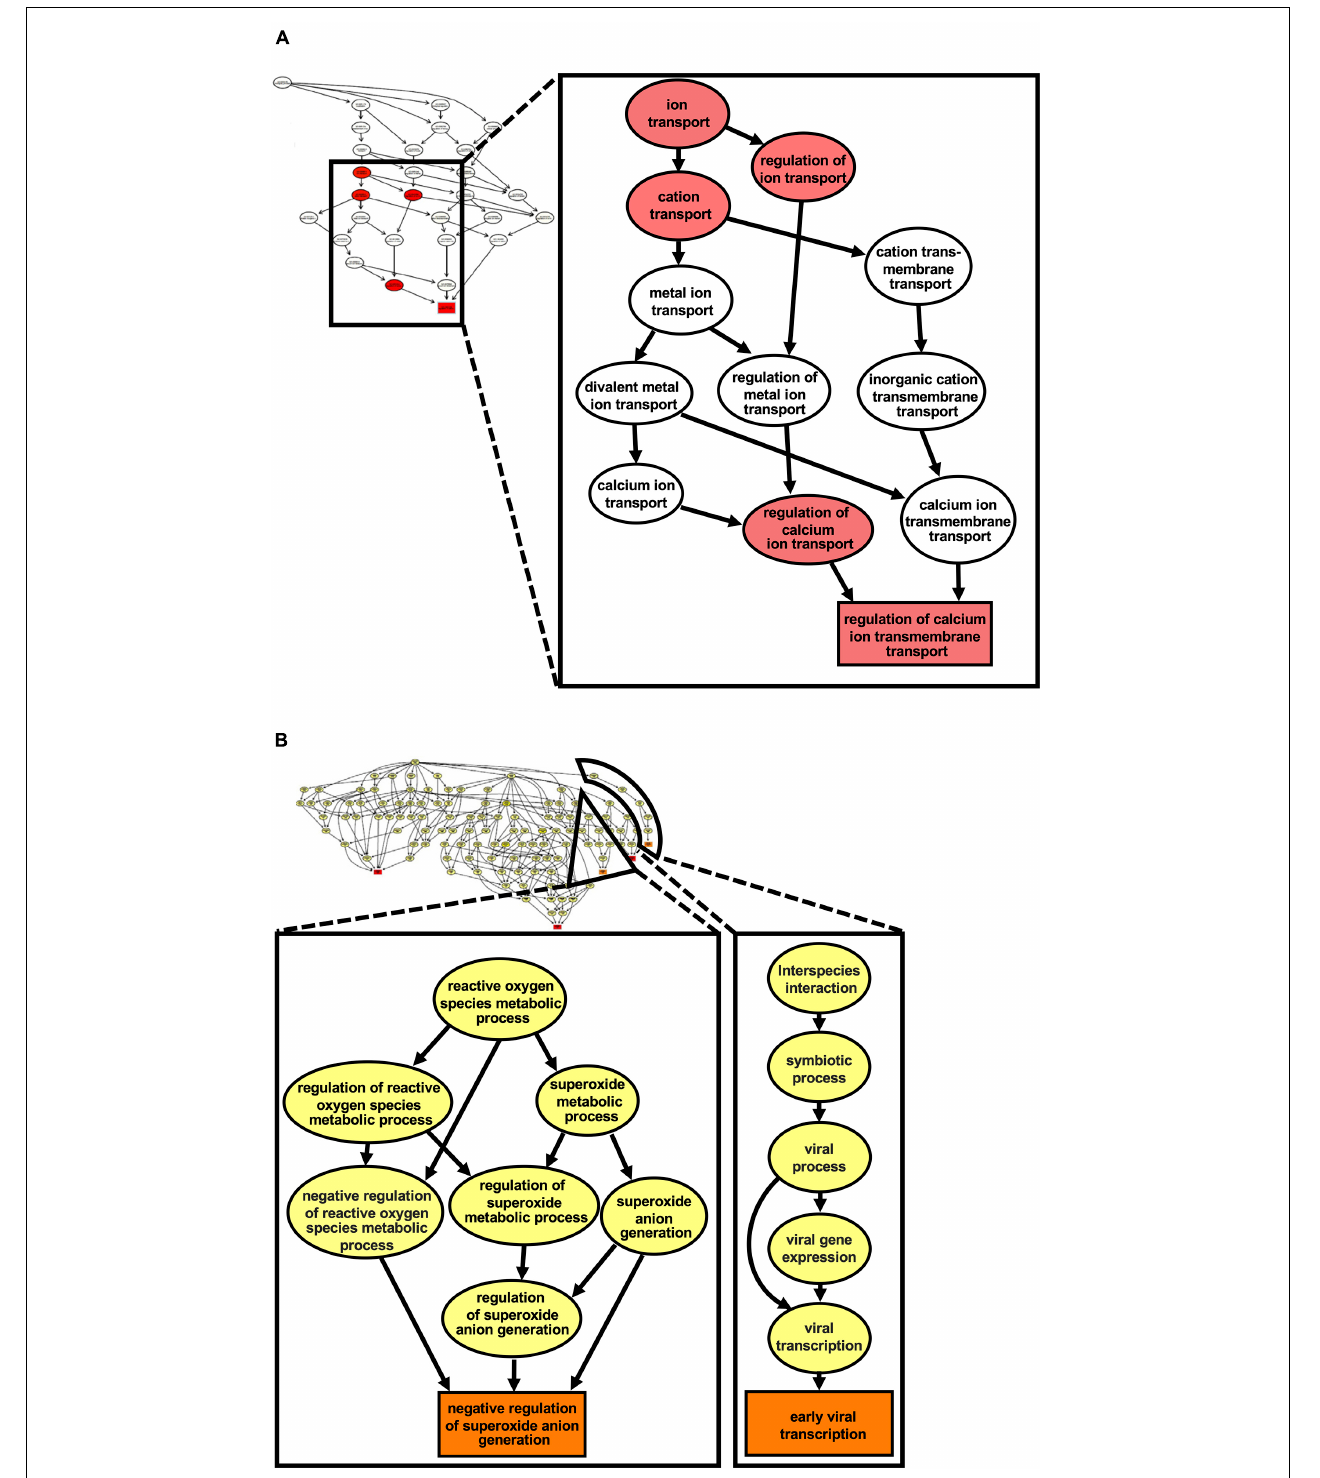
FIGURE 6 | Ca 2 + transmembrane transport pathways are altered in the liver of RHDV2- infected rabbits. A gene ontology (GO) enrichment analysis was conducted using the list of differentially expressed genes from RNA sequencing. (A) The graph induced by the top 5 GO terms identified by the weight01 algorithm (Alexa et al., 2006); the square shape indicates the most significant GO term. (B) The graph induced by the top 5 GO terms identified by weight01 algorithm with Fisher exact test also identified pathways associated with viral infection and regulation of reactive oxygen species generation. Box colors represents the relative significance of GO terms, from white (least significant) to red (most